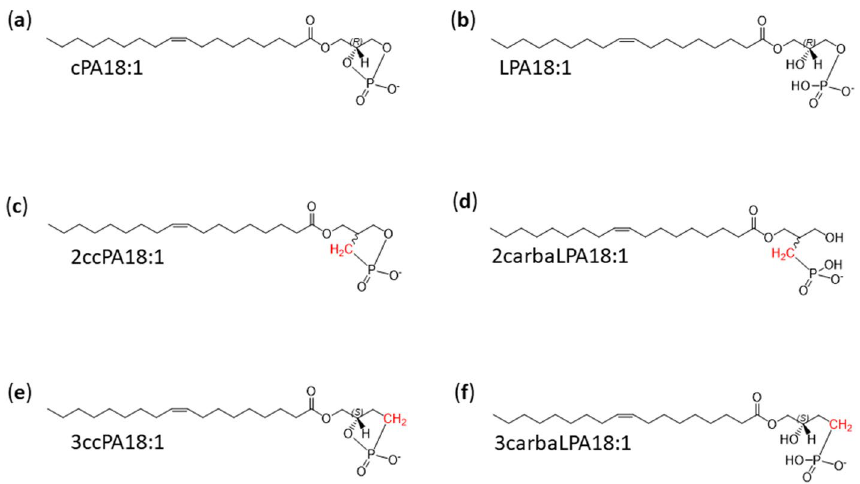
Figure 1. Chemical structure of ( a ) cyclic phosphatidic acid (cPA 18:1), ( b ) lysophosphatidic acid (LPA 18:1), ( c ) 2-carba-cyclic phosphatidic acid (2ccPA 18:1), ( d ) 2-carba-lysophosphatidic acid (2carbaLPA 18:1), ( e ) 3-carba-cyclic phosphatidic acid (3ccPA 18:1), and ( f ) 3-carba-lysophosphatidic acid (3carbaLPA